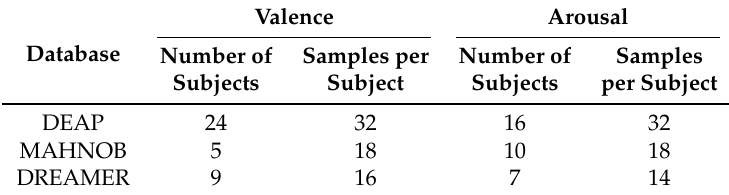
Table 2. Number of subjects and samples per subject in each dataset, after